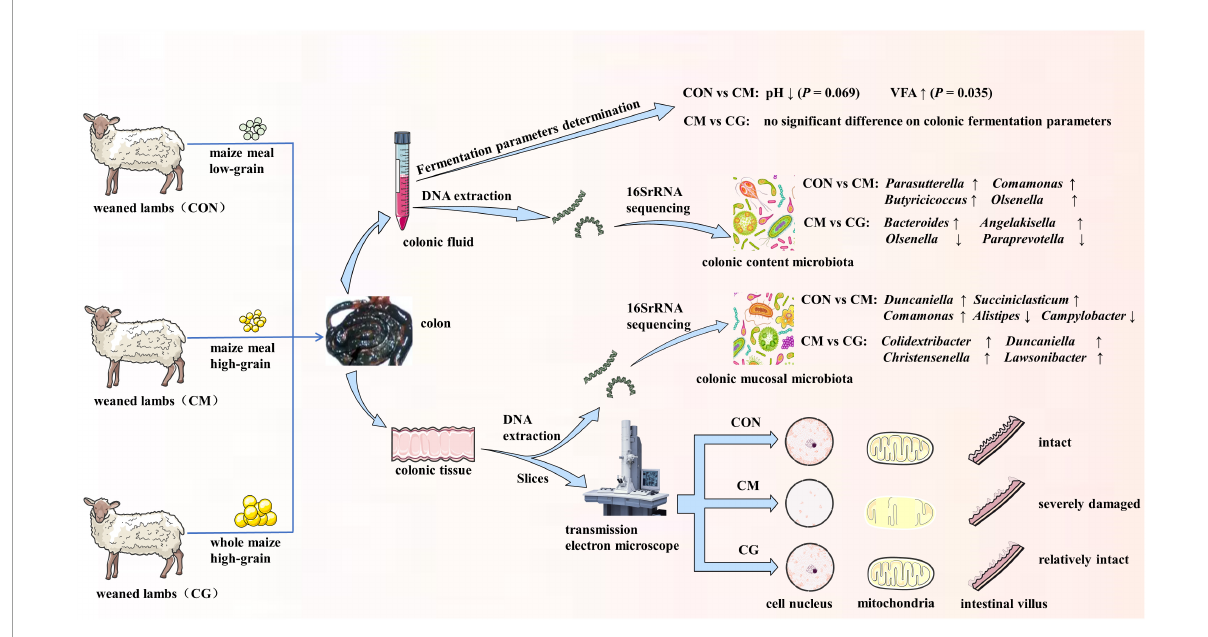
FIGURE7 The schematic diagram of experimental design and main results in this